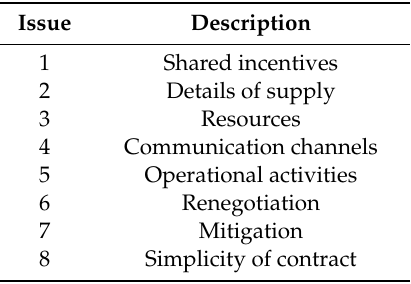
Table 3. Issues to account for to ensure e ffi cient heat supply